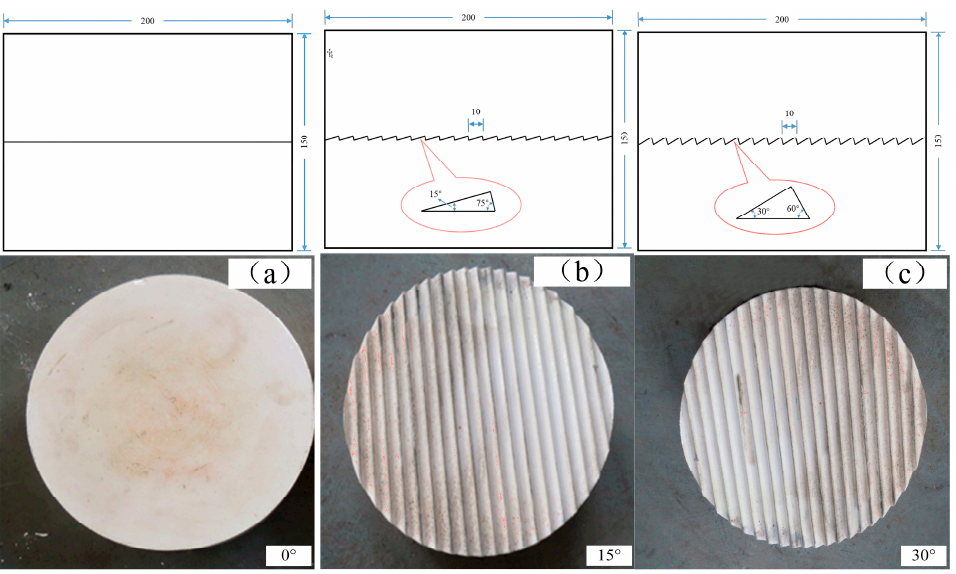
Figure 3. Diagram of artificial joint samples: ( a ) joint roughness is 0°; ( b ) joint roughness is 15°; ( c ) joint roughness is 30° (unit: mm). roughness is 30 ◦ (unit: mm). Table 1. Shear strength parameters of intact cylindrical specimens. Table 1. Shear strength parameters of intact cylindrical